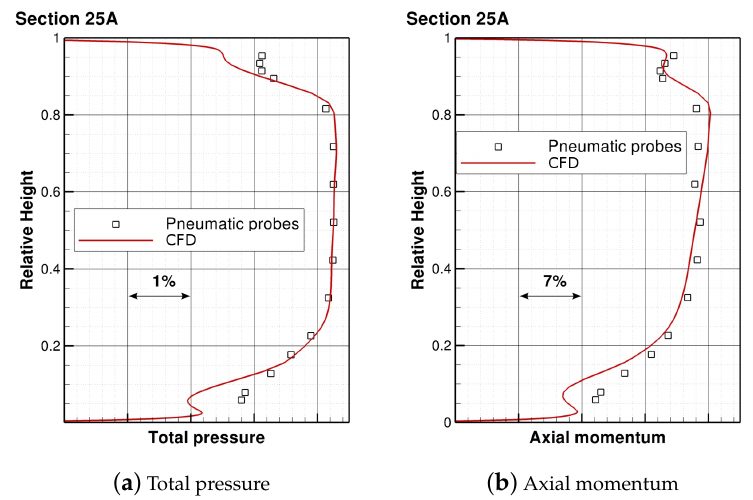
Figure 3. Radial profiles at inlet plane